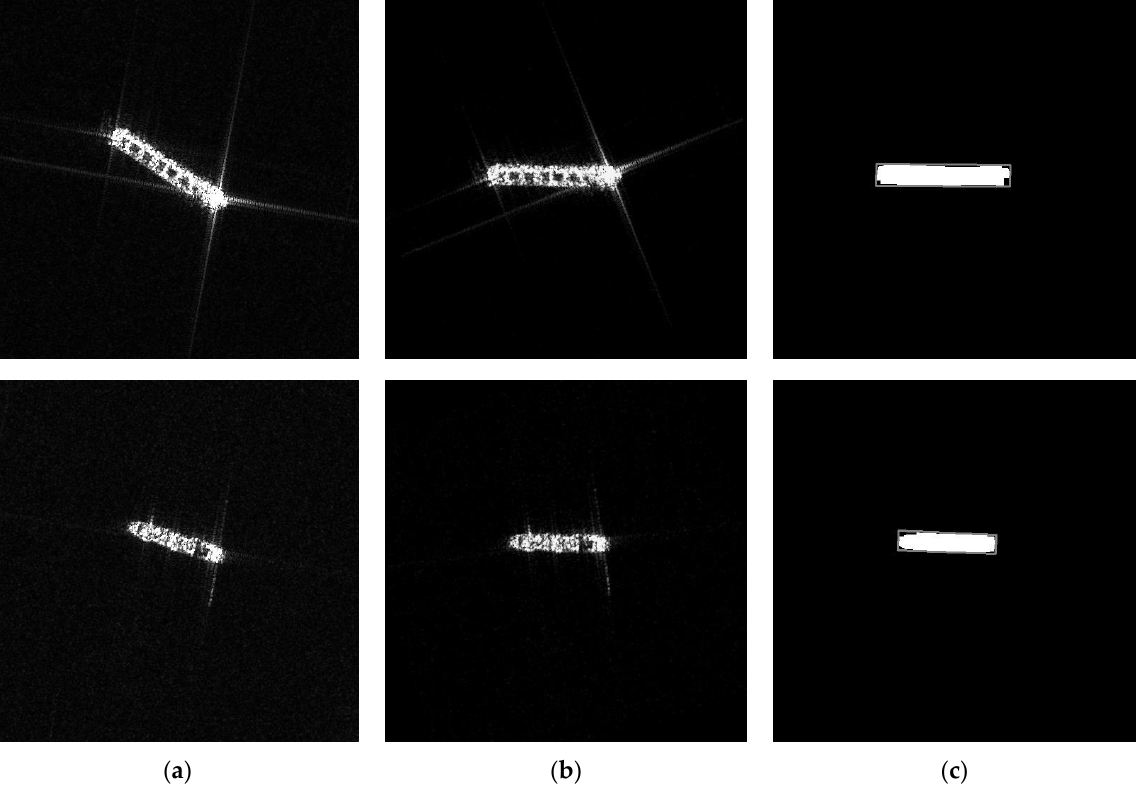
Figure 5. Geometric feature extraction of ship objects in SAR images. ( a ) Original SAR images; ( b ) Radon-transformed SAR images; and ( c ) ship MBR extraction.